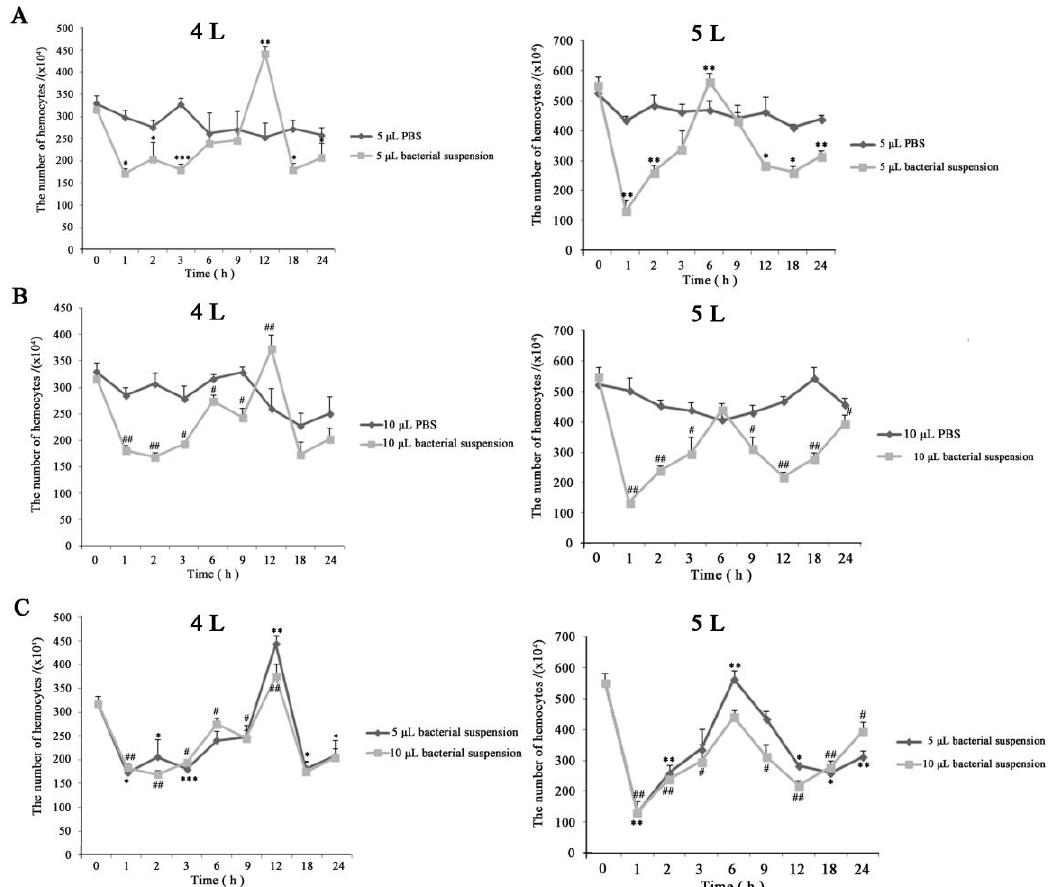
Figure 3. The change of hemocyte numbers in hemocoel after infection; 4 L: fourth instar larvae; 5 L: fifth instar larvae. Statistically significant differences are denoted with */# ( p < 0.05), **/## ( p < 0.01) or ***/### ( p < 0.001) for injecting 5 and 10 μL, respectively. ( A , B ) The variations in hemocyte numbers of larvae injected PBS or E. coli for 5 and 10 μL, respectively. ( C ) The merged diagram of the change tendency of hemocyte numbers after injection of 5 and 10 μL E. coli .